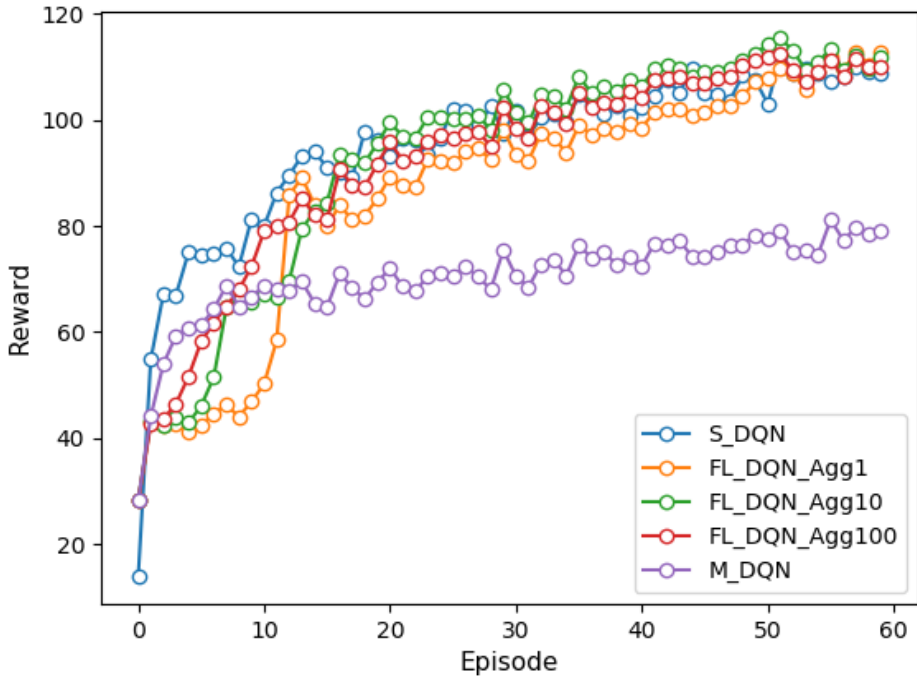
Figure 2. Comparison of reward of DQN methods under episodes.